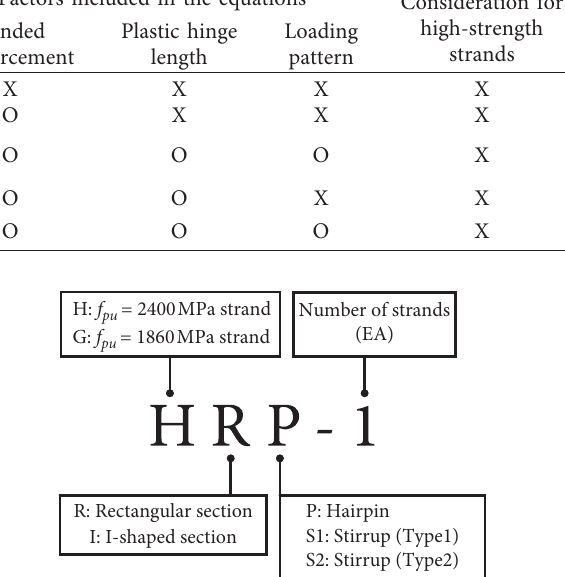
Table 1: Comparison of the parameters considered in the proposed equations and the provisions in ACI and AASHTO. Factors included in the equations Parameters used in the equations for stress in Authors/Code unbonded strands